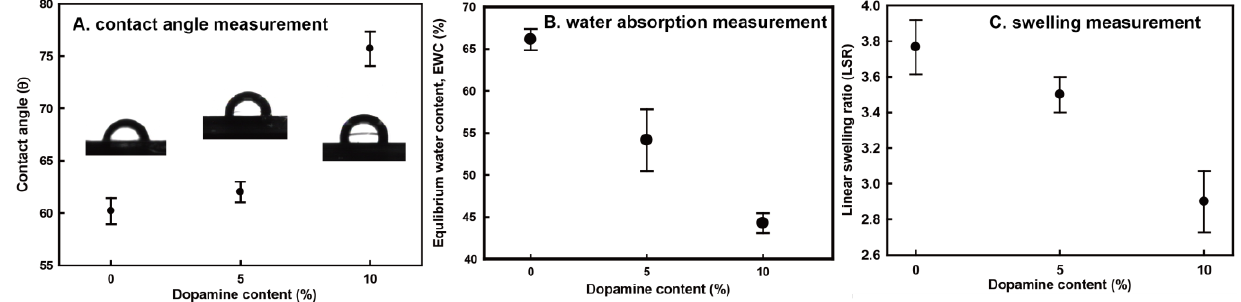
Figure 2. ( A ) Water contact angle; ( B ) equilibrium water content (EWC); and ( C ) linear swelling ratio (LSR) values of pure regenerated chitin, 5 wt % dopamine-containing composite and 10 wt % dopamine-containing composite. Each value represents the